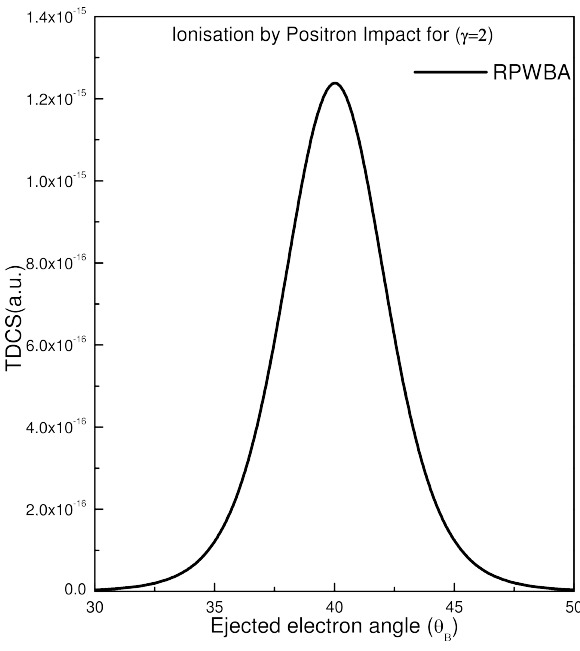
Figure 3. Same as in Figure 1 but for T i = 510.999 keV and T B = 255499 eV.